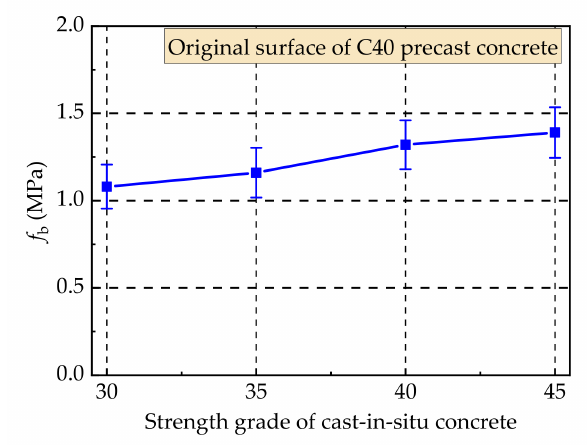
Figure 6. Bonding strength of interface changed with different strength of cast-in-situ